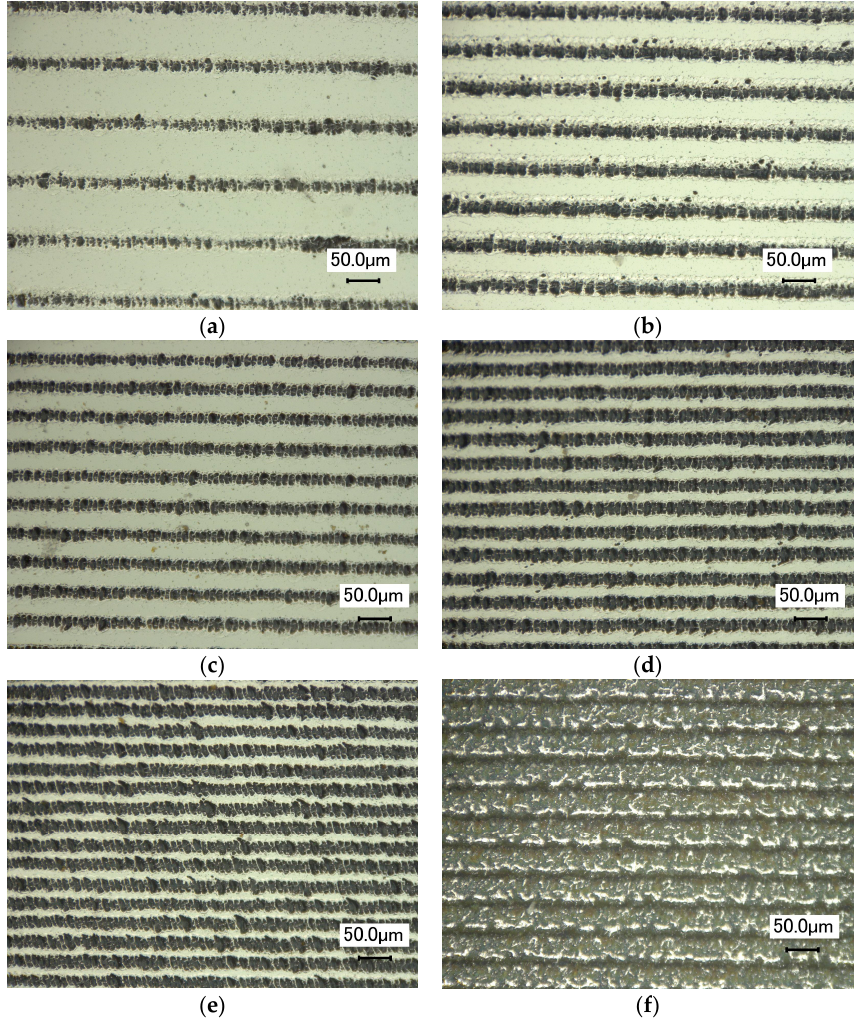
Figure 8. Optical images of gratings fabricated on Al film: ( a ) d = 50 μ m, ( b ) d = 38.2 μ m, ( c ) d = 28.1 μ m, ( d ) d = 13.9 μ m, ( e ) d = 10 μ m, and ( f ) d = 0 μ m. The frequency of gratings is ( a ) 10 lines/mm, ( b ) 15 lines/mm, ( c ) 20 lines/mm, ( d ) 25 lines/mm, ( e ) 30 lines/mm, and ( f ) 35 lines/mm. The energy of laser pulse is 9.8 μ J .